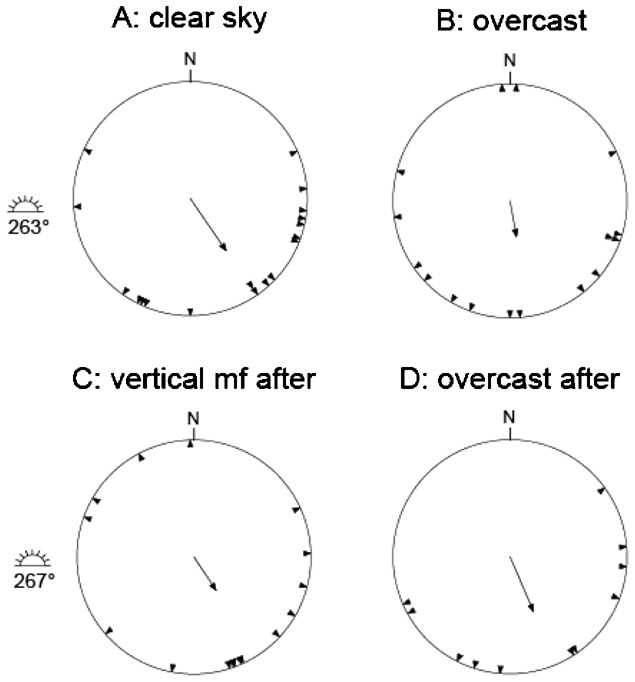
Results from our outdoor orientation cage experiments with juvenile sedge warblers, Acrocephalus schoenobaenus at Stensoffa Ecological Field Station in South Sweden during autumn migration.(A) Clear sky, (B) overcast sky, (C) exposure under clear skies without magnetic cues at vertical magnetic field vector, and (D) simulated overcast as a control after cue-conflict exposure. For further information, see legend for Fig. 1.